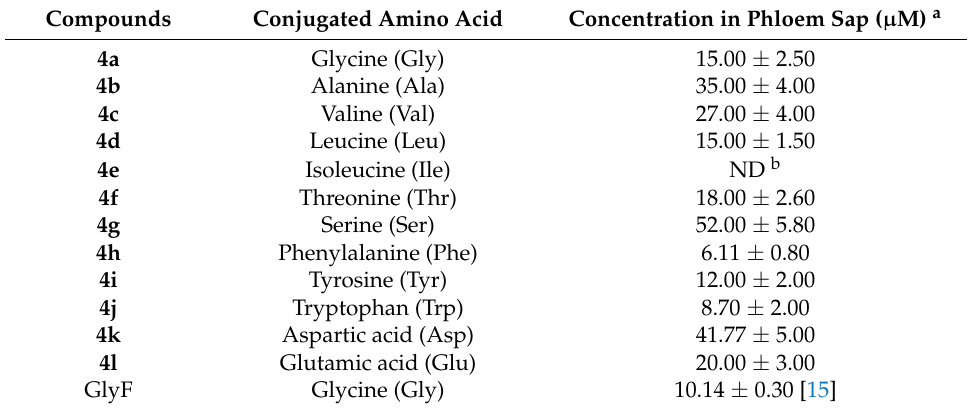
Table 1. Concentrations of compounds 4a – l and GlyF in phloem sap of castor bean seedlings.